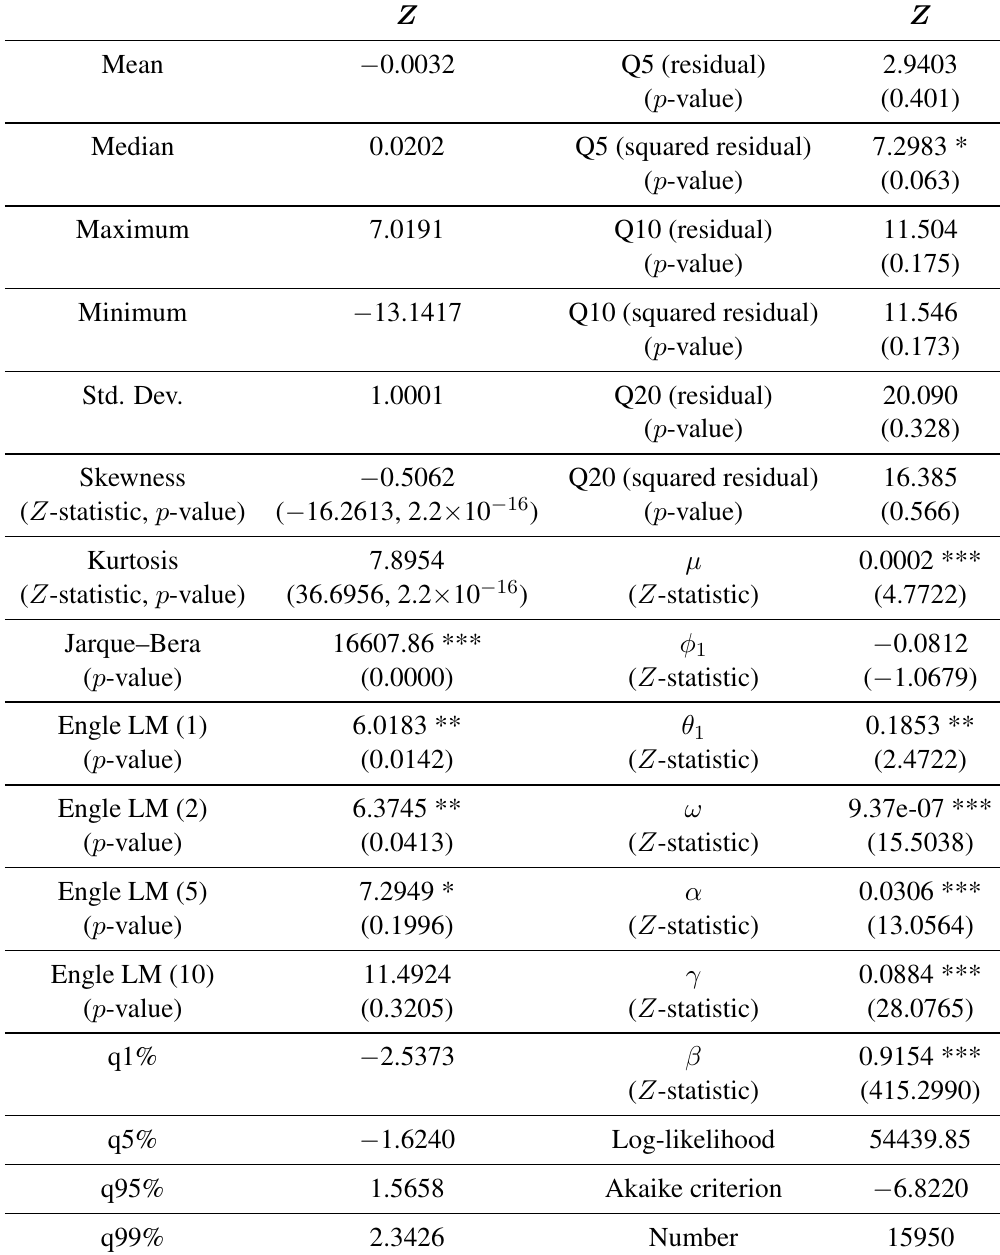
Table 1. Descriptive statistics. The Table presents the descriptive statistics of the S&P 500 stock index standardized daily log-returns ( Z ) from 3 January 1950 to 31 May 2013. Sample: 15,950